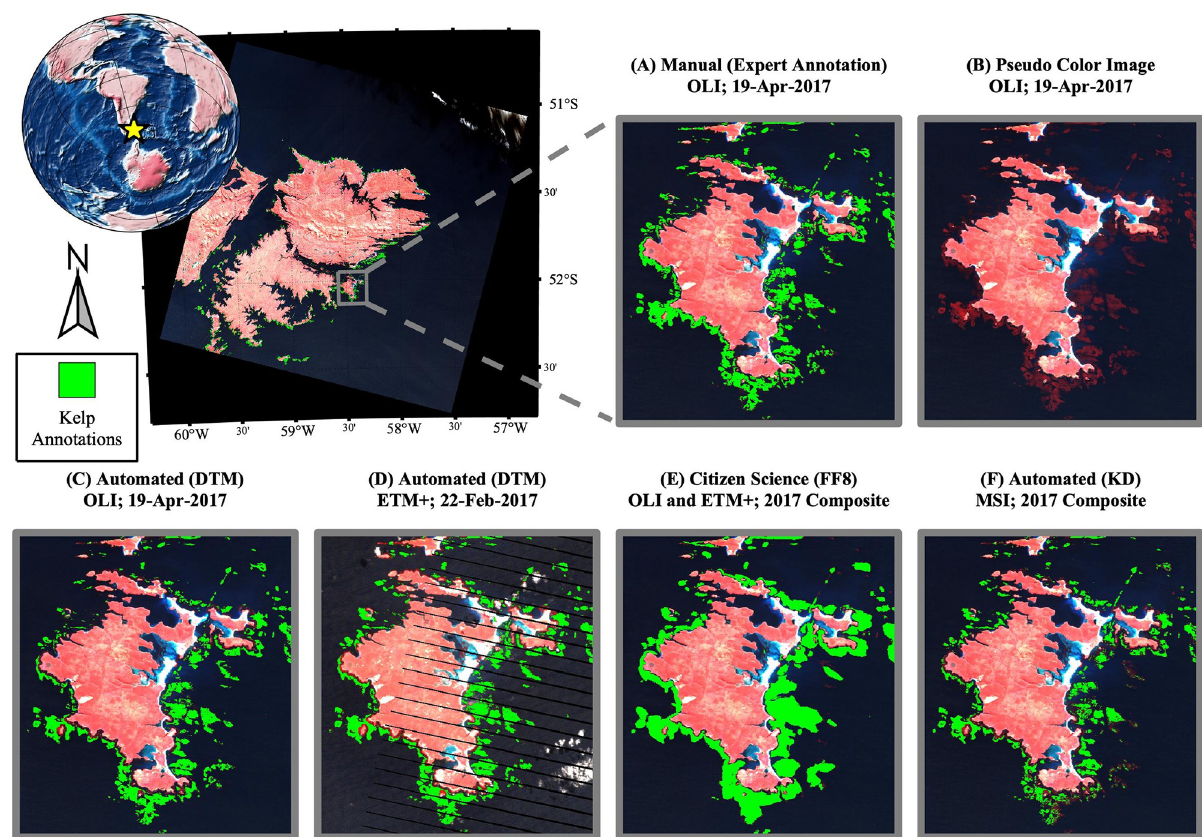
Fig 3. Comparison of kelp classification methods. A pseudo-color scene of East Falkland is shown in the upper left panel with expert kelp classifications indicated in green. The figure inlays show various automated and manual methods, as well as non-annotated imagery, for a smaller spatial region, as follows: (A) manual classifications performed on a single OLI scene by an expert technician; (B) pseudo-color (NIR/red/green) image; (C) DTM automated classifications of a single OLI scene; (D) DTM automated classifications of a single ETM+ scene; (E) FF8 consensus classifications of OLI imagery during 2017; and (F) KD automated classifications of MSI imagery during